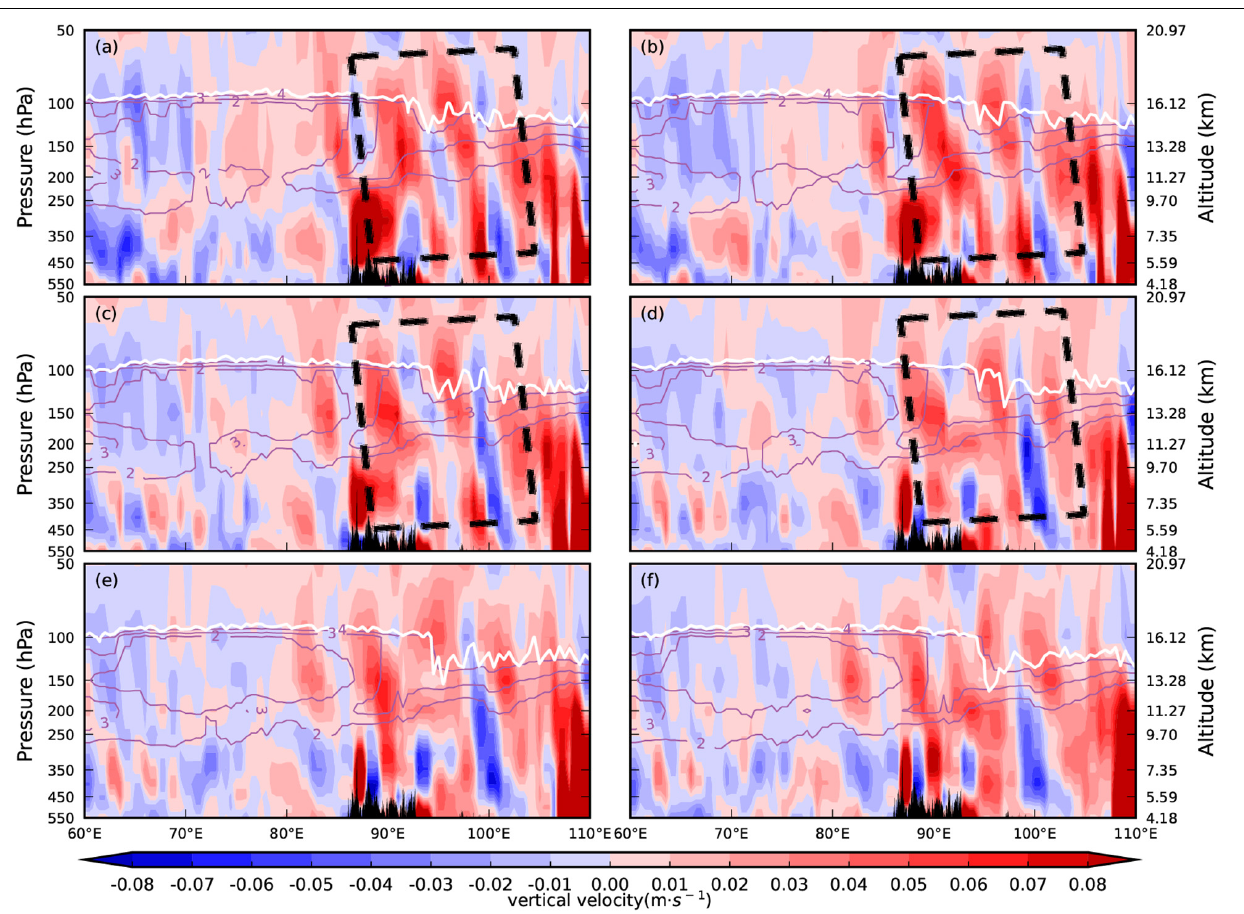
FIGURE 9 | Longitude–height cross section of vertical velocity (unit: m s − 1 ) along 28 ◦ N simulated by WRF. The solid white lines indicate the thermal tropopause and the solid purple lines indicate potential vorticity (unit: PVU). Times shown are (a) 18:20; (b) 19:20; (c) 20:20; (d) 21:20; (e) 22:20; and (f) 23:20.